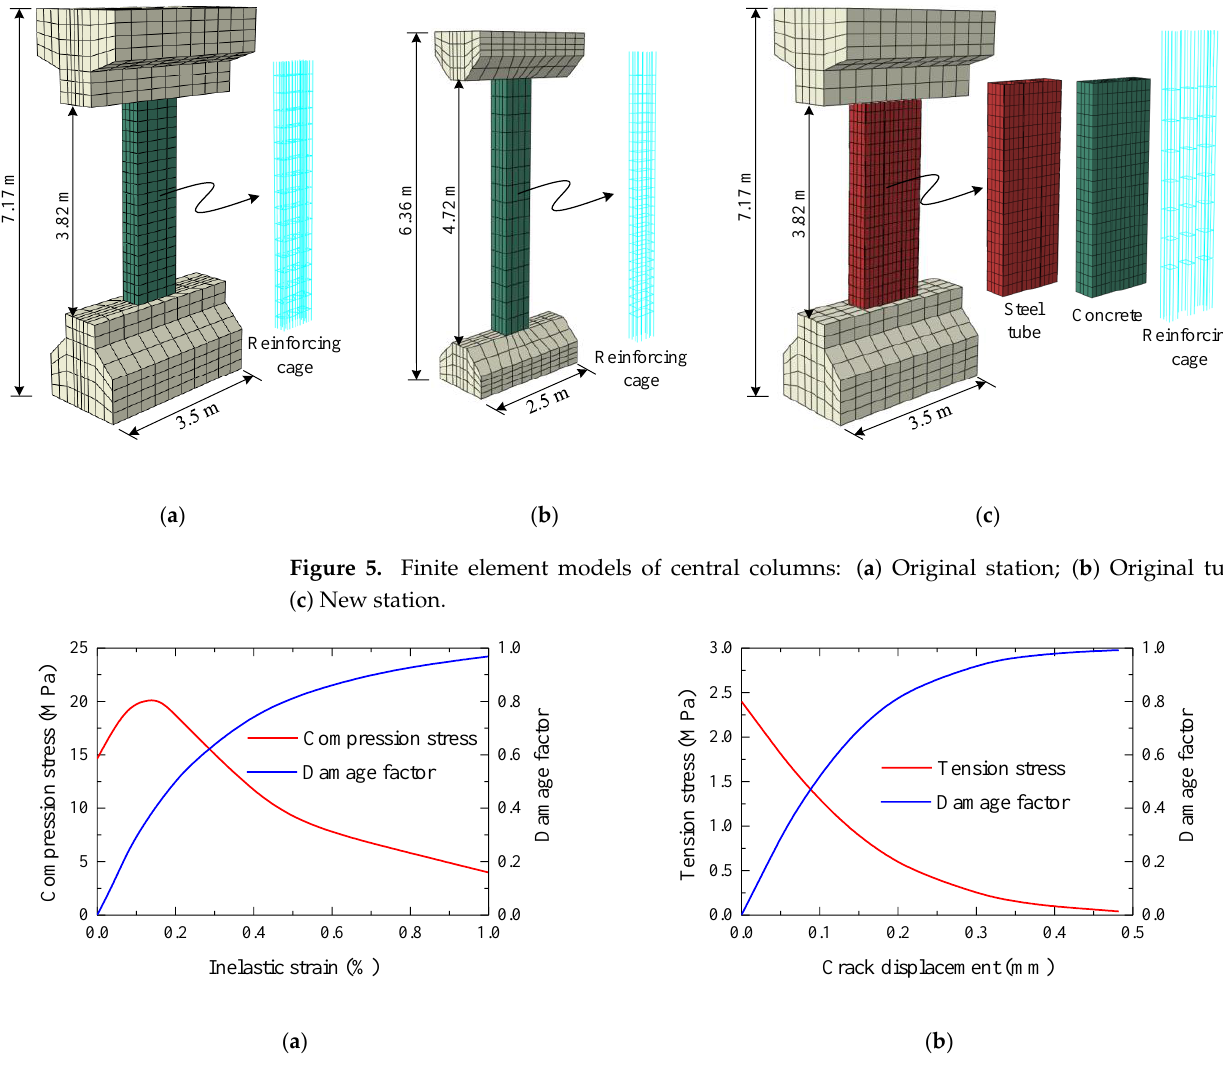
Figure 6. Material parameters of concrete: ( a ) Compressive behavior; ( b ) Tensile behavior.